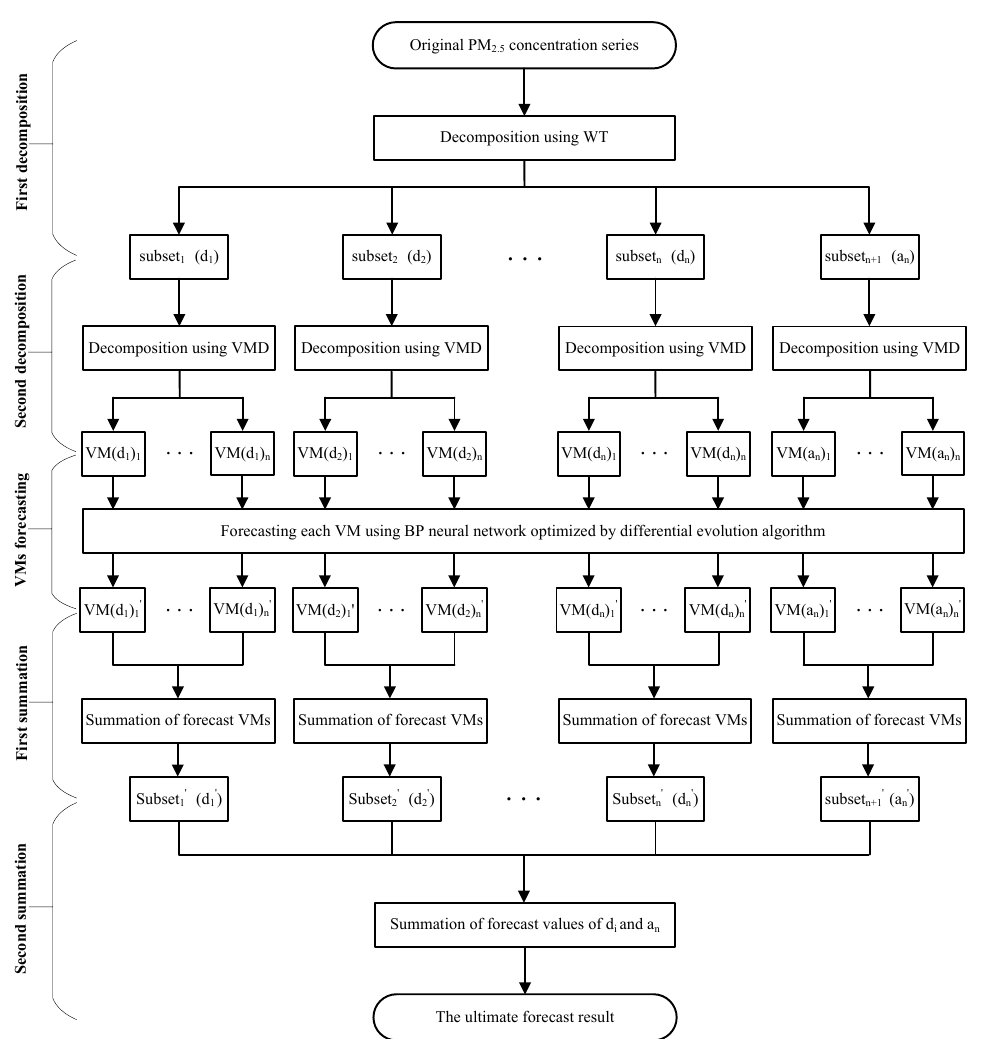
Figure 5. The flowchart of WT-VMD-DE-BP model.